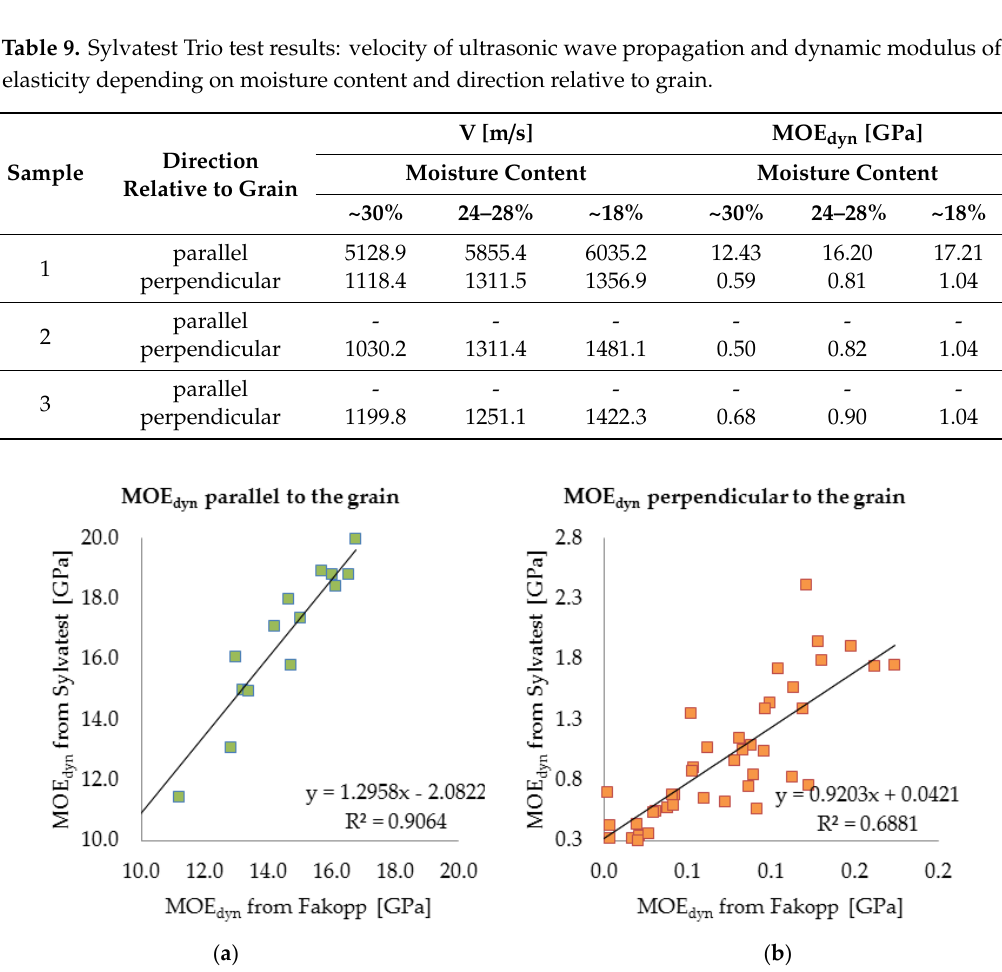
Figure 11. Correlation between dynamic modulus of elasticity determined using ultrasonic wave method (Sylvatest) and stress wave method (Fakopp) for all the samples for all moisture content levels for both directions relative to grain: ( a ) parallel; ( b ) perpendicular.